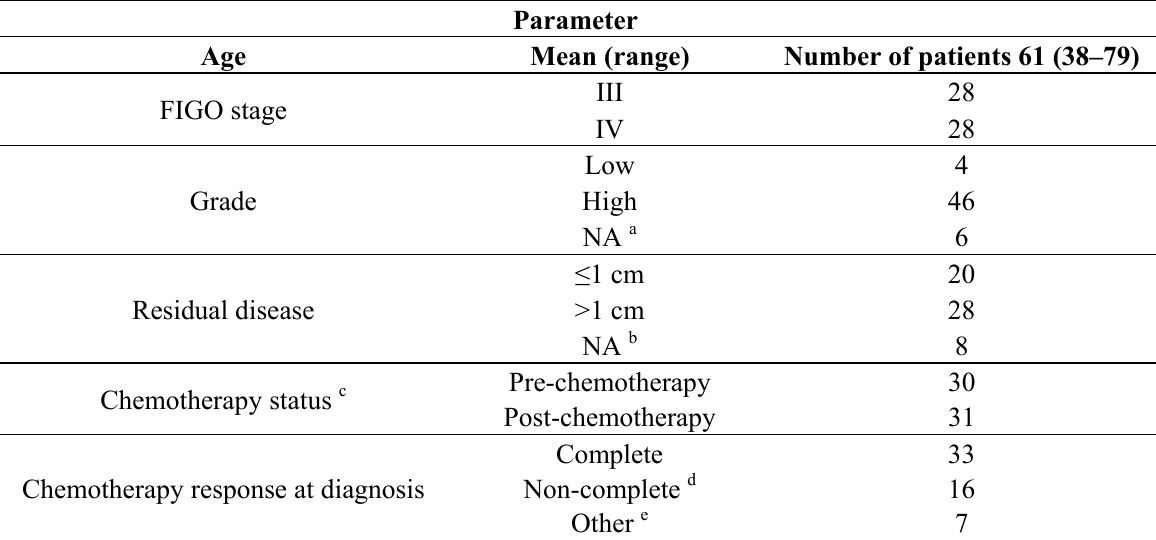
Table 1. Clinicopathologic data of the effusion cohort (56